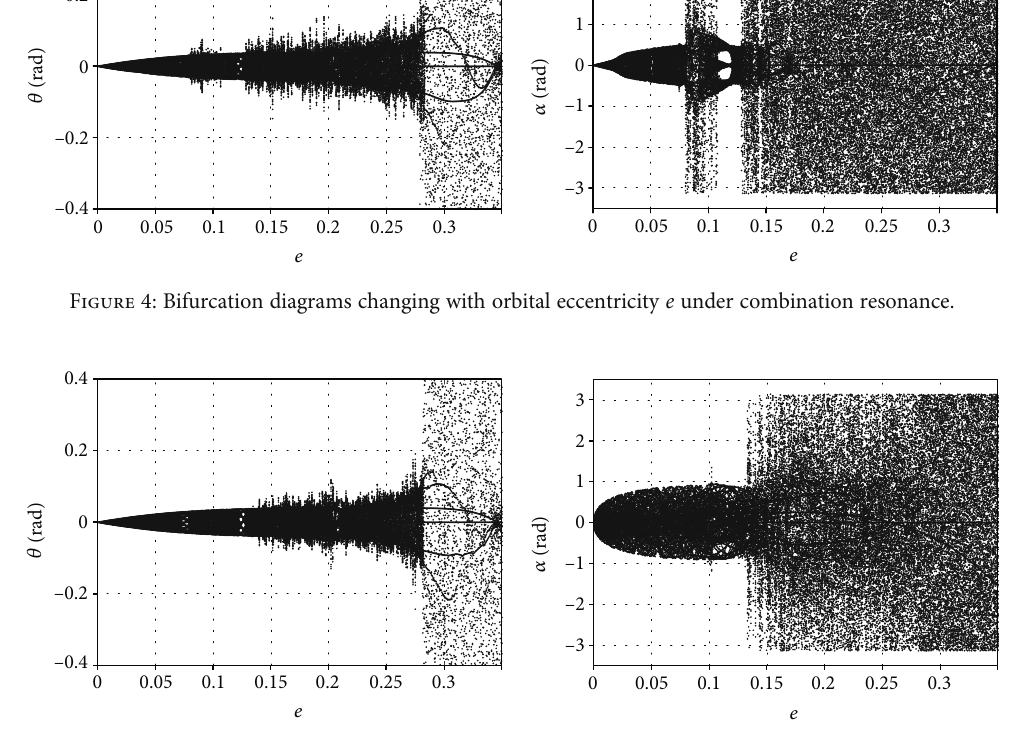
Figure 5: Bifurcation diagrams changing with orbital eccentricity e under primary